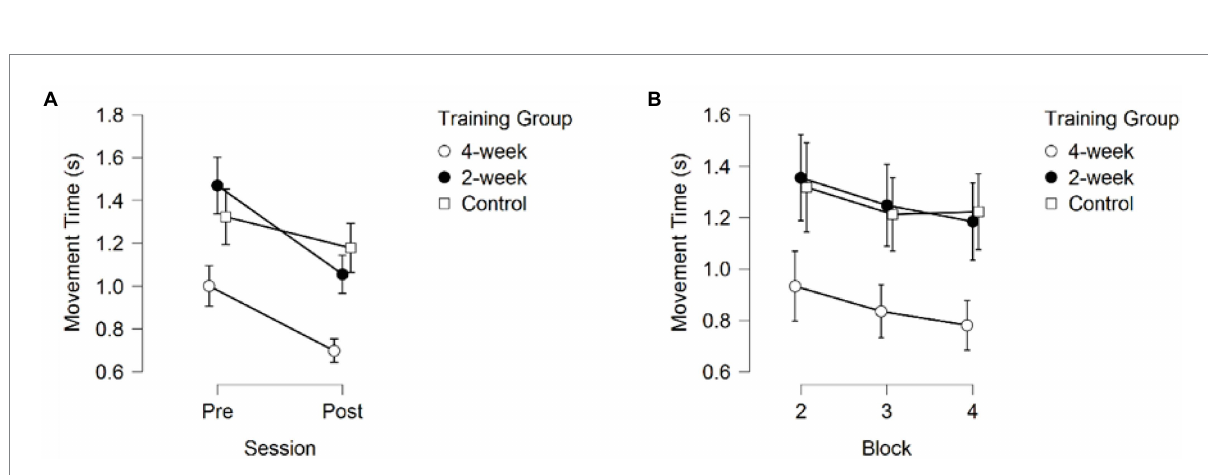
FIGURE 5 Movement time (A) across sessions, averaged over the three blocks (B) across blocks, averaged over the pre- and post-session. Error bars represent 95% CIs between